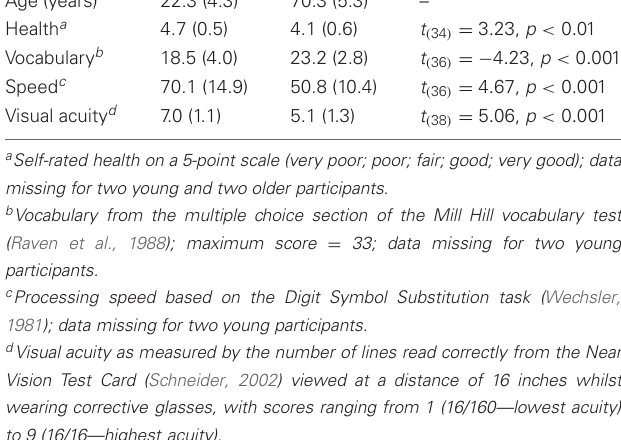
Table 1 | Background details (means and standard deviations) of young and older participants, and results of comparisons between age groups.